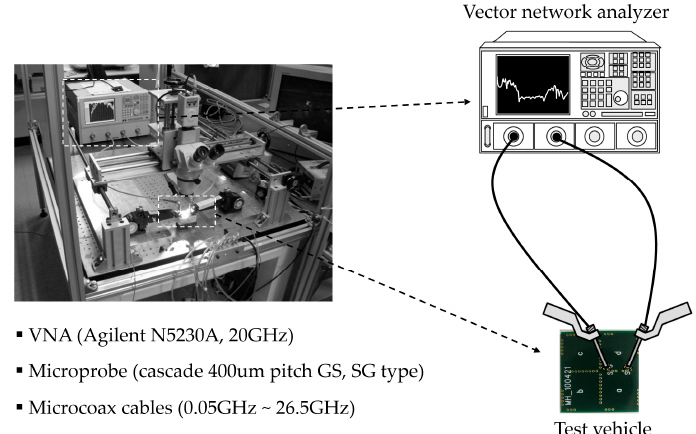
Figure 9. Measurement setup for the noise suppression characteristics.